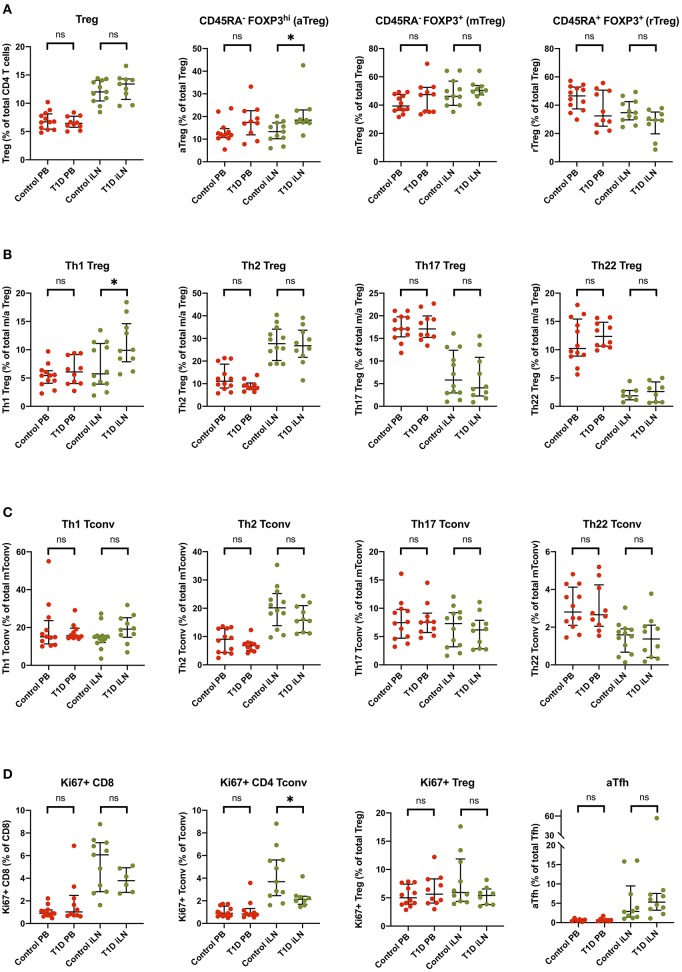
Subtle alterations in the balance of T cell subpopulations between T1D and control individuals are evident in iLN but not in blood. Individual frequencies of (A) naïve/memory Treg cell subsets (B), T helper-like Treg subsets (C), conventional helper T cell subsets, and (D) proliferation and activation marker on T cell subsets in blood and iLN from control and T1D subjects. Frequencies of each cell type are expressed as a percentage of total T cell subtype. Error bars represent median and inter quartile ranges for each population. ANOVA or Kruskal-Wallis test was used. *p<0.05. ns, not significant.